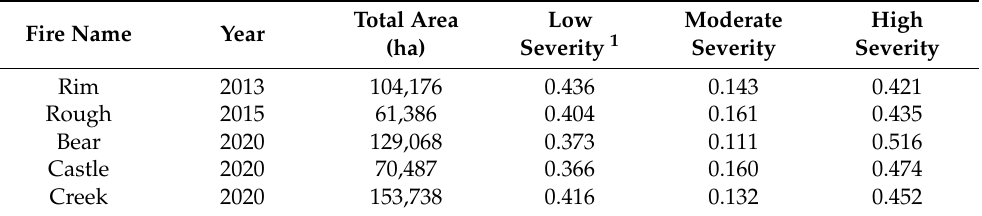
Notes: 1 Low severity (<25% basal area mortality), moderate severity (25%–75% basal area mortality), and high severity (>75% basal area mortality) as determined by